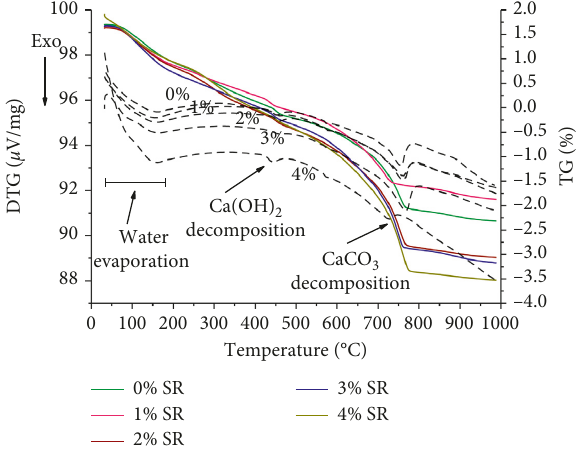
Figure 1: TGA result of cement pastes with different dosages of